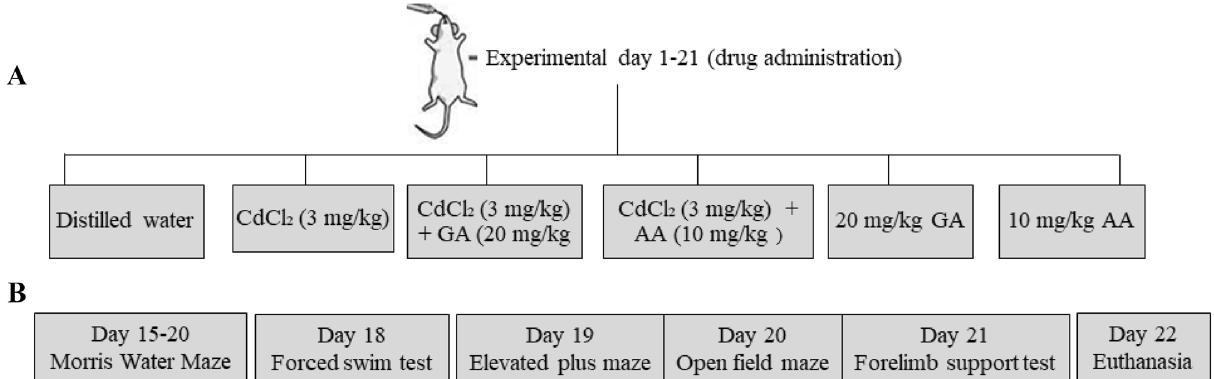
Figure 1. ( A ) Schematic diagram of experimental groups ( B ) Outline of behavioral